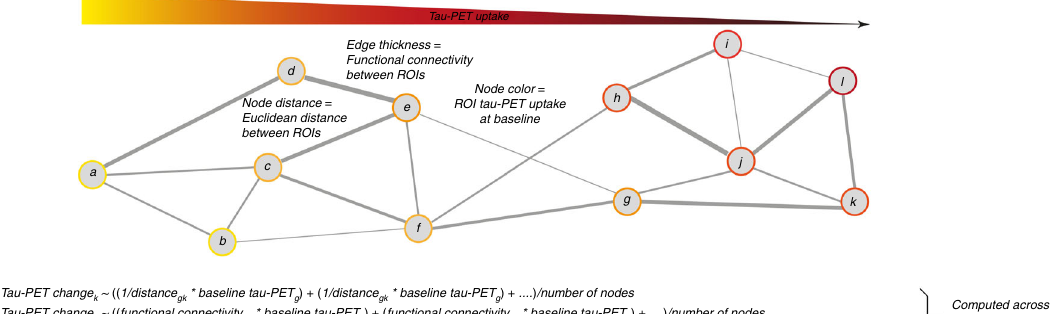
Model1: Tau weighted by distance